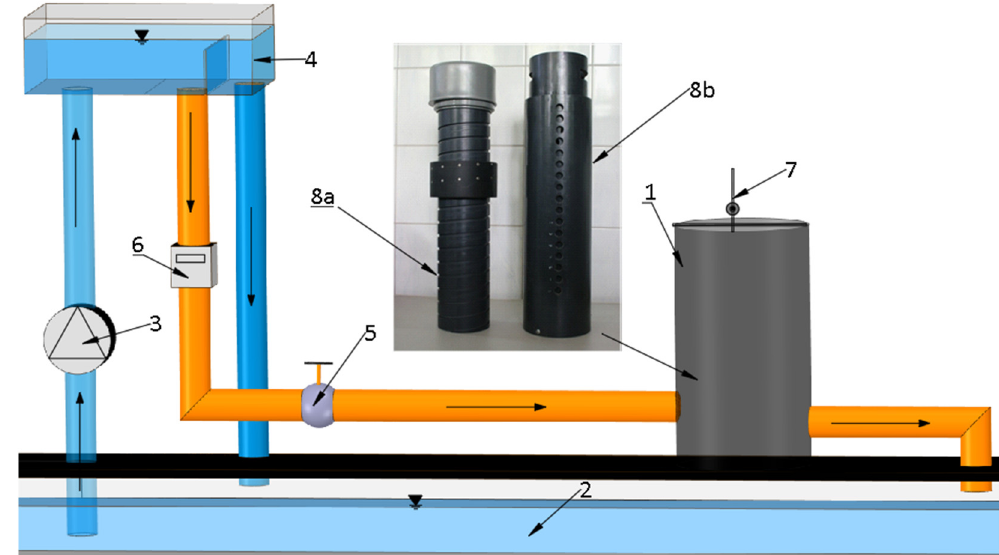
Figure 1. Scheme of the entire test stand: 1—manhole; 2—down tank; 3—pump; 4—upper stability tank; 5—regulating valve; 6—electromagnetic flow meter; 7—precise water gauge staff; 8—rotary regulators of water damming in the drains: 8a funnel, 8b hole.